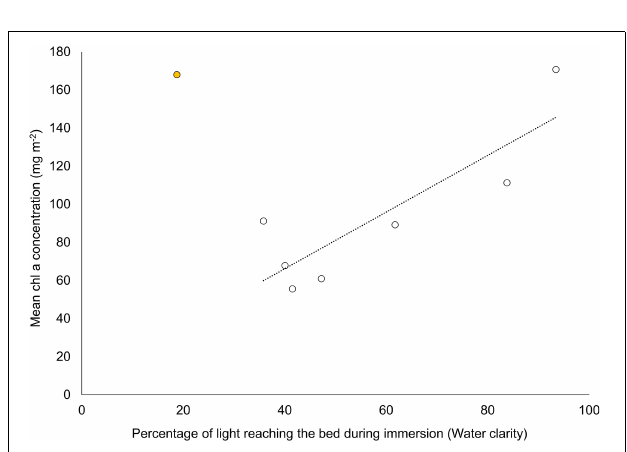
FIGURE 6 | Relationship between MPB biomass (chl a concentration, mg m - 2 , ± SE, n = 3) and water clarity, see Figure 2B ( r 2 = 0.73). Inclusion of site MK (shaded circle) reduced the explained variation ( r 2 ) from 0.73 to 0.07.